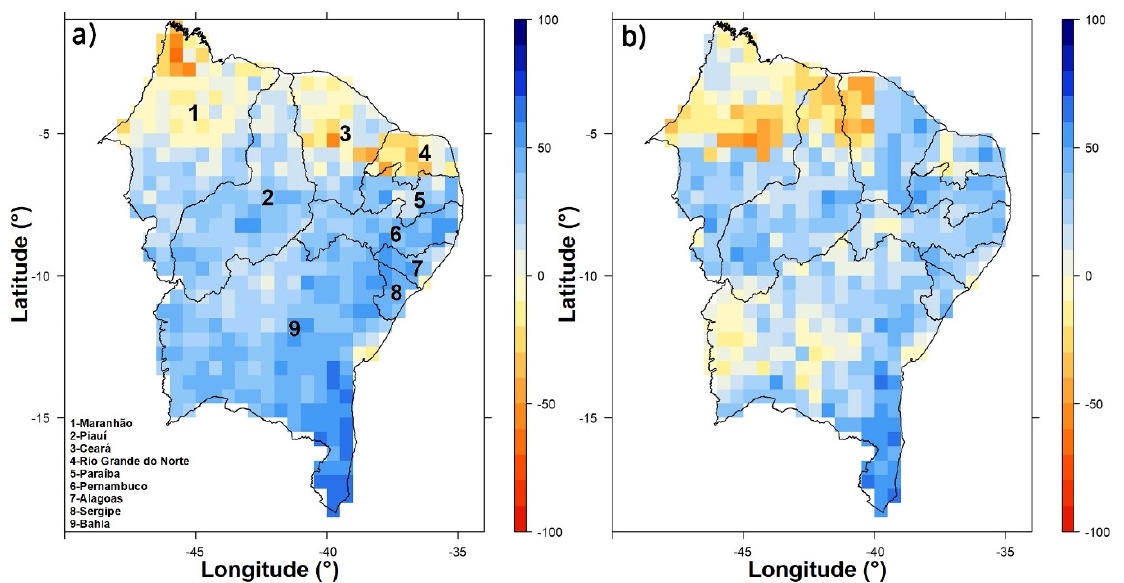
Figure 9. Brier skill score (BSS) for values below ( a ) and above ( b ) the normal for the EmpM in relation to the NMME.